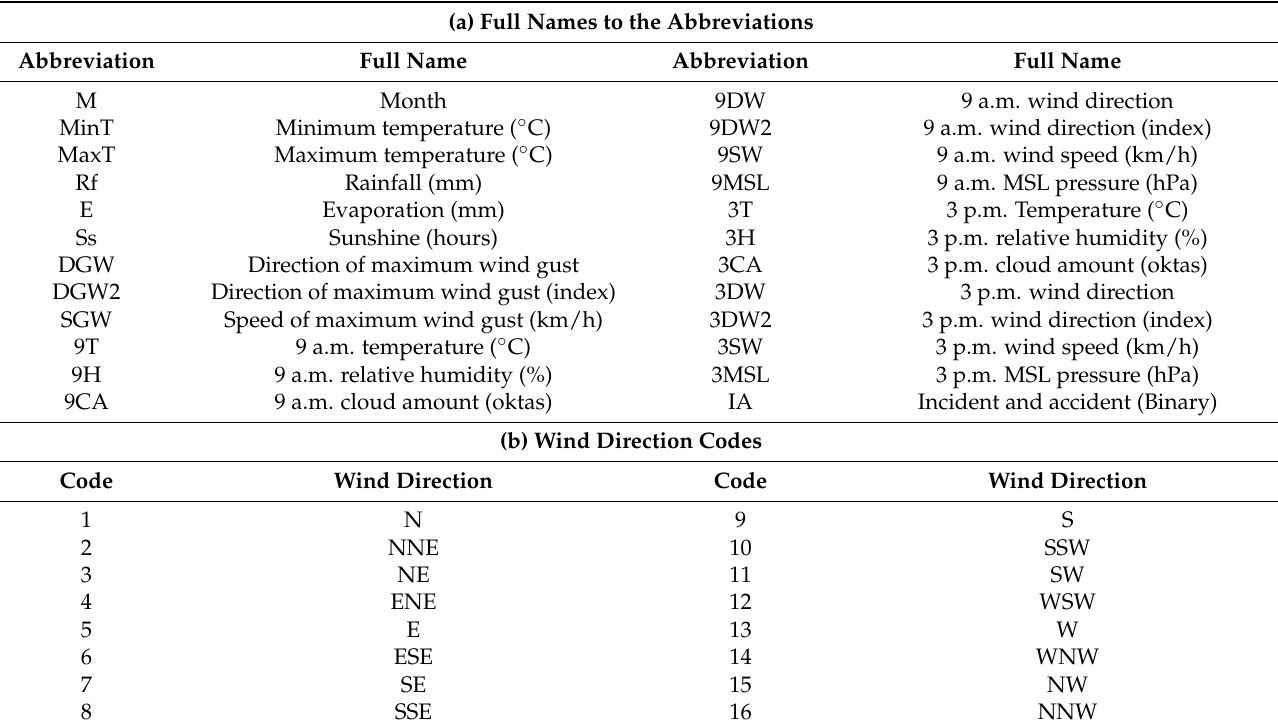
Table 2. ( a ) Full names to the abbreviations. ( b ) Wind direction codes. (a) Full Names to the